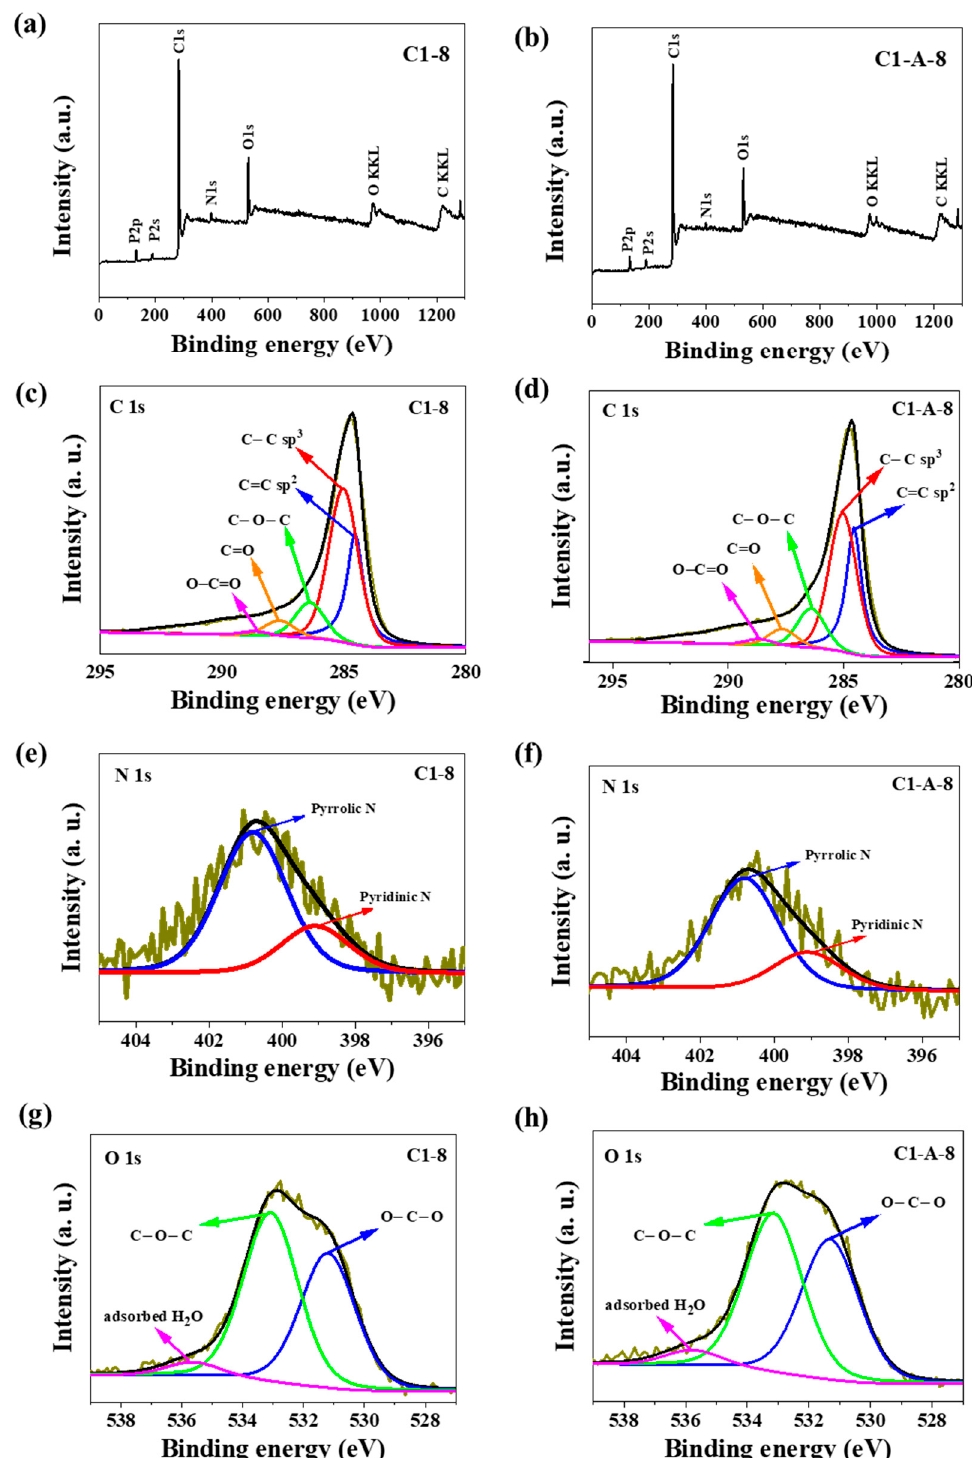
Figure 4. XPS survey spectra ( a , b ) and high-resolution XPS spectra for C1s, N1s, and O1s of ( c , e , g ) C1-8; and ( d , f , h ) C1-A-8. and ( d , f , h )